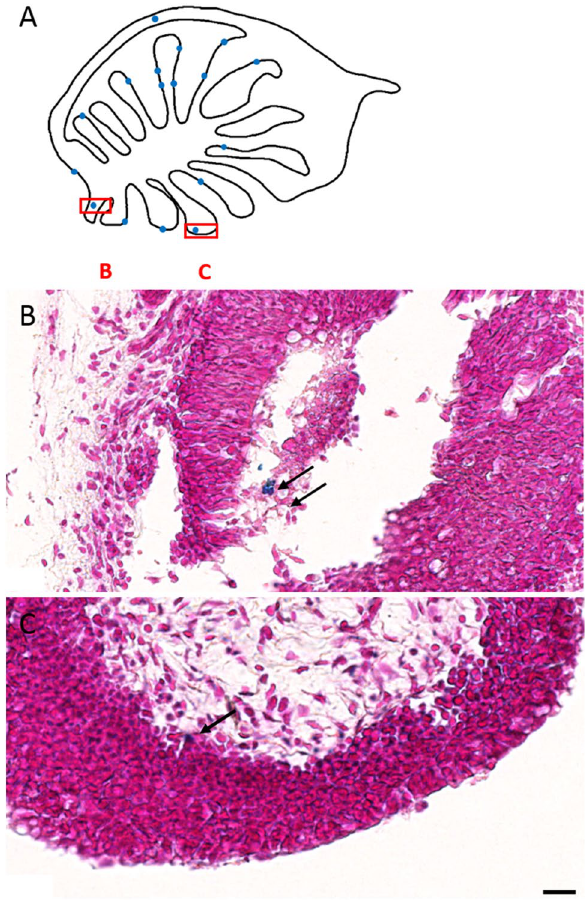
Figure 4. Prussian Blue (PB) stained olfactory rosette from rainbow trout, counterstained with nuclear fast red. ( A ) Camera lucida view of a horizontal section of the olfactory capsule, showing lamella with olfactory epithelium folds branching off the central raphe. PB positive sites, marked as blue dots, are by and large located at the luminal side of the olfactory epithelium and most likely represent contamination from external iron-rich particles sticking to the epithelium. ( B ) An example of a large PB stained feature (arrow) between epithelial cells, in close proximity to the lumen, and a second smaller one located in the lumen above. ( C ) A PB positive site at the basal layer of the epithelium, close to the apex of a lamella fold, where candidate magnetoreceptor structures have been identified earlier 42,43,61 . Upon closer look, however, this seemingly promising site is rather defocused compared to the surrounding tissue and turns out to lie above the tissue, so that it therefore most likely represents an external iron-rich particle entrained in the sectioning process. Scale bars 20